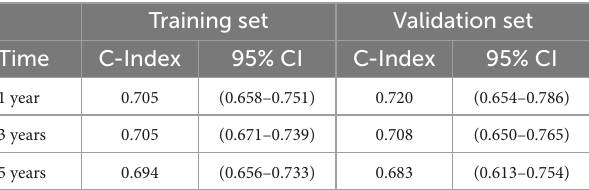
TABLE 3 Time-dependent receiver operating curves (ROC) for training and validation sets. Training set Validation